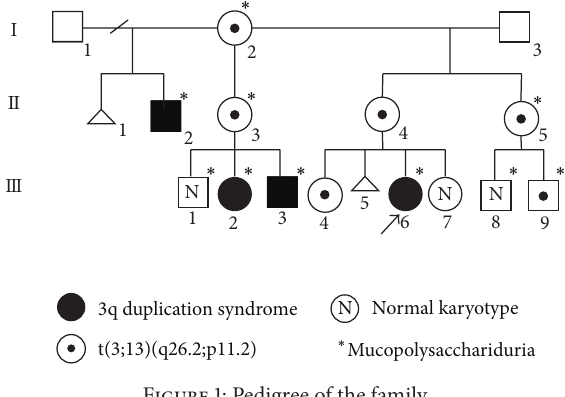
Figure 1: Pedigree of the